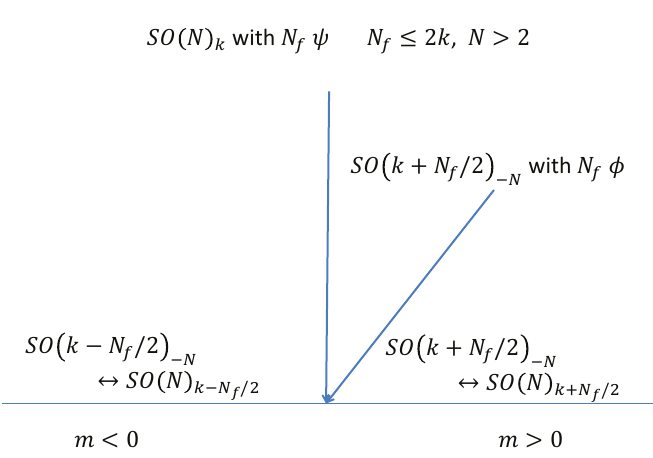
Figure 3 . The phase diagram of SO( N ) k for N f (cid:20) 2 k .